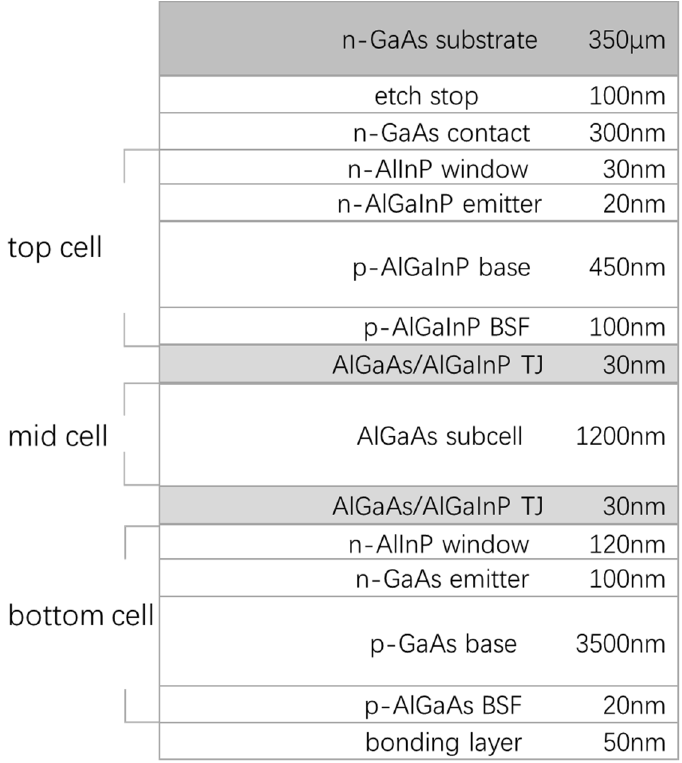
Figure 1. Schematic cross-section structure of inverted GaAs T-3J sub-cell.